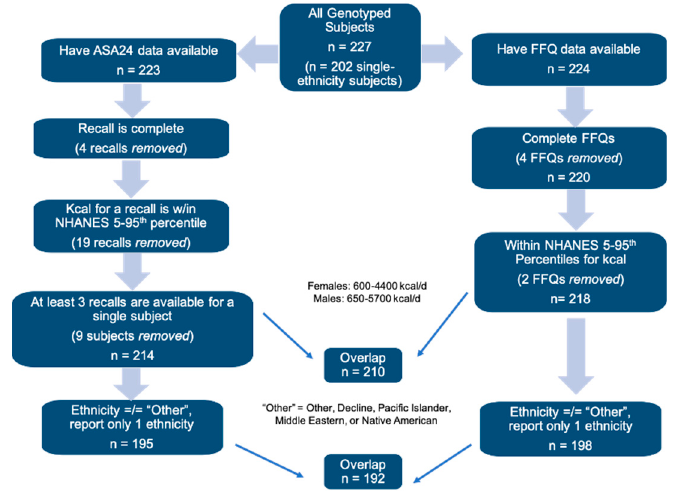
Figure 1. Flow chart for subject inclusion criteria for food frequency questionnaire (FFQ) or Automated Self-Administered 24-h recall system (ASA24 ® ) analyses.